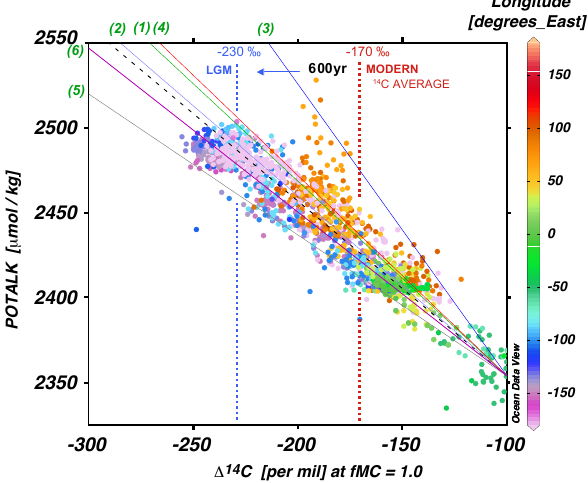
Fig. 4. Potential alkalinity (POTALK) vs. 1 14 C in modern ocean waters below 2000mw.d., based on volumetrically unweighted GLODAP data (Key et al., 2004), showing the differential influence of deep-ocean calcite dissolution on total alkalinity in six major ocean regions (green numbers at upper left) as delineated in Fig. 3. Regression slopes are − 1.15 (1), − 1.06 (2), − 1.71 (3), − 1.18 (4), − 0.83 (5), and − 0.96 µmolkg − 1 per ‰ 1 14 C (6). Global aver- age regression line ( − 1.03µmolkg − 1 per ‰ 1 14 C) is hatched. Color scale indicates eastern longitudes of deep waters. Vertical dotted lines mark modern and LGM average ventilation ages of 1500/2100 14